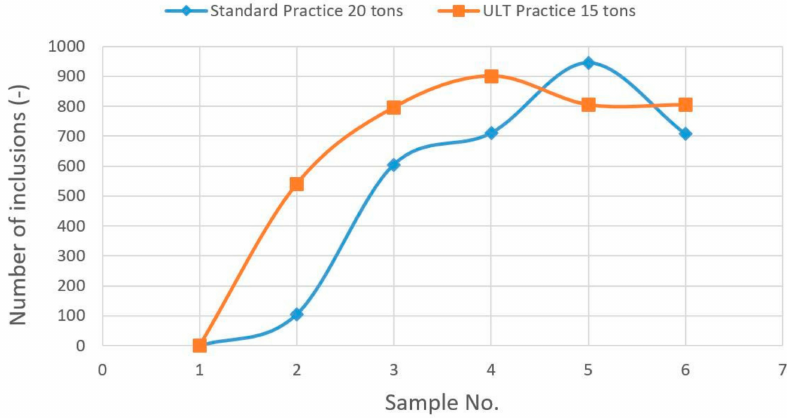
Figure 6. Comparison of the course of total Si–O inclusions in the different A and B grade joining conditions (standard vs. ULT practice).